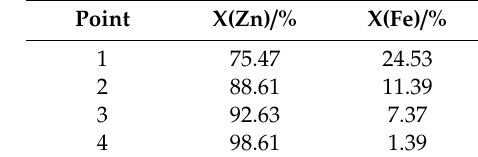
Table 2. Composition of points 1 to 4 in Figure 3 by EDS analysis.